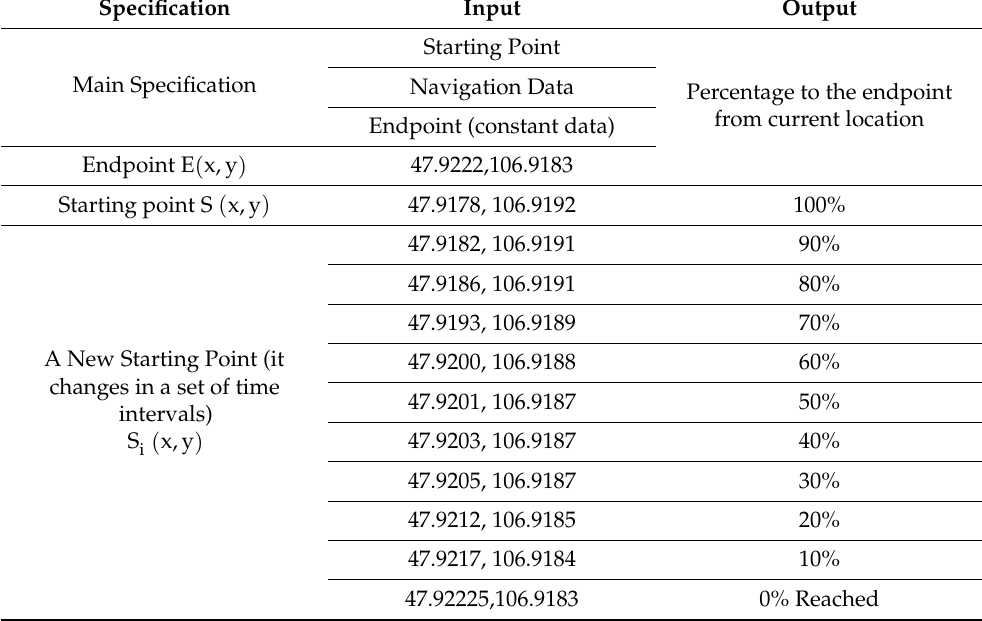
Table 8. A specification of distCalc and sample